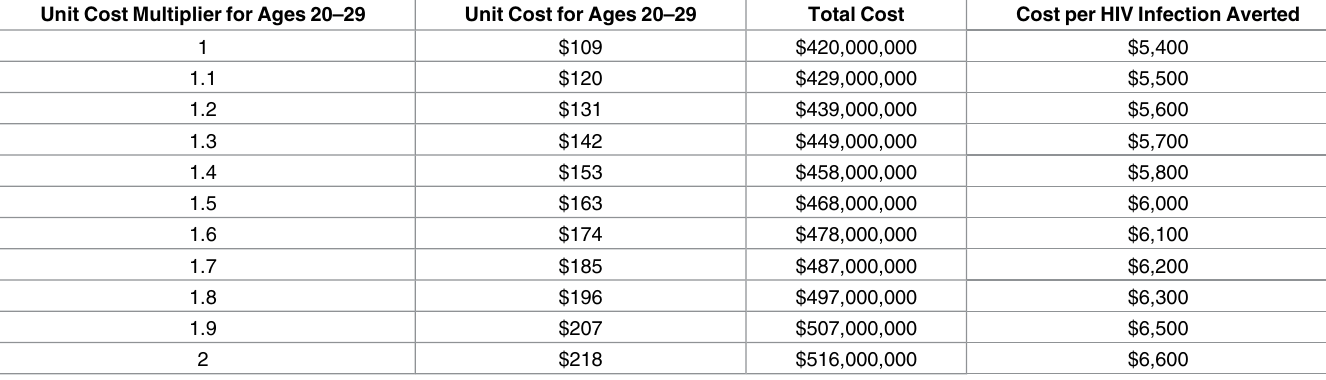
Table 3. Sensitivity Analysis of Unit Cost for Circumcising Males Ages 20–29 in Scenario A 1 . Unit Cost Multiplier for Ages